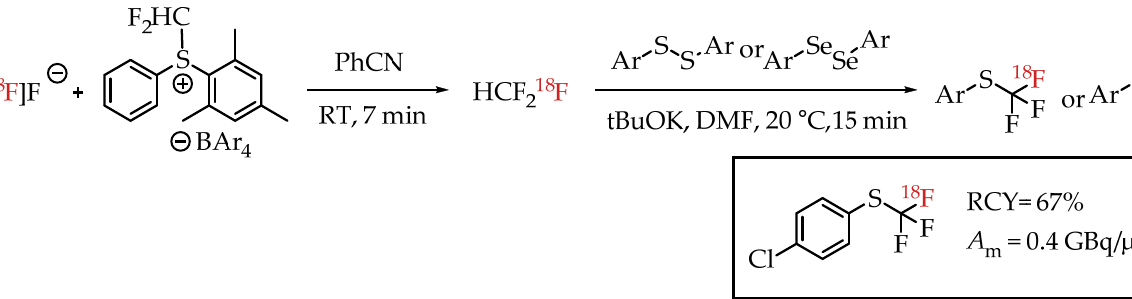
Figure 11. ( A ) [ 18 F]Trifluoromethyl cysteine synthesis from cyclic sulfamidates. ( B ) Static PET images of C6 glioma-bearing